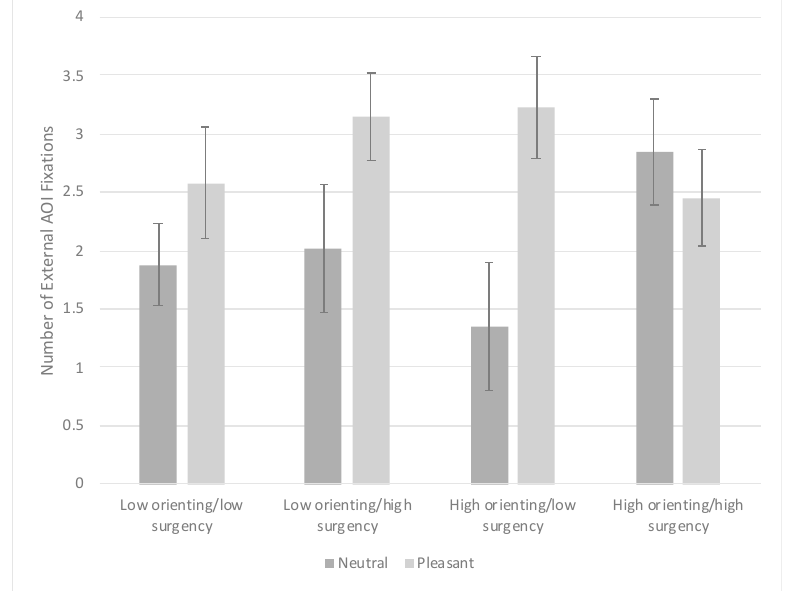
Figure 6. Number of fixations toward the external features of the familiarized face based on facial expression and infants’ orienting and surgency. Bars represent standard error.